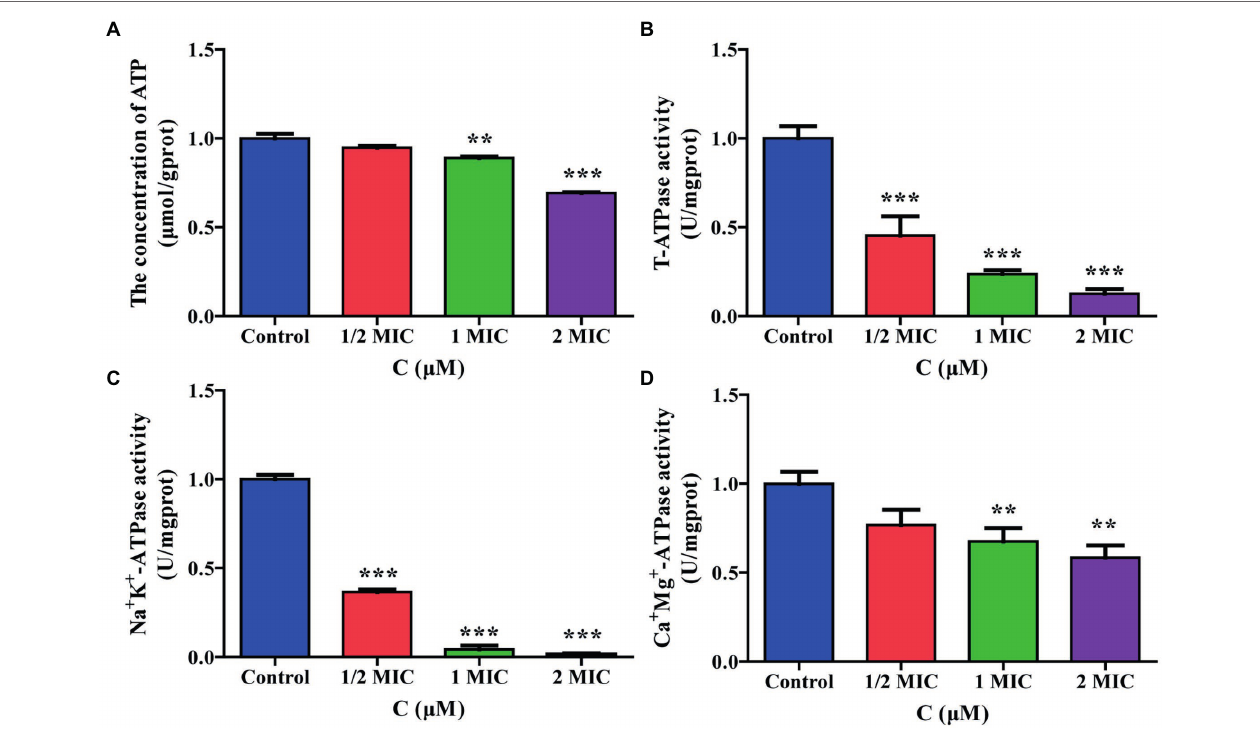
FIGURE 8 | Effect of moringin on energy metabolism in Listeria monocytogenes . (A) ATP levels exposure to different concentrations of moringin. (B) T-ATPase activity exposure to different concentrations of moringin. (C) Na + K + -ATPase activity exposure to different concentrations of moringin. (D) Ca 2+ Mg 2+ -ATPase activity exposure to different concentrations of moringin. * p < 0.05, ** p < 0.01, and *** p <